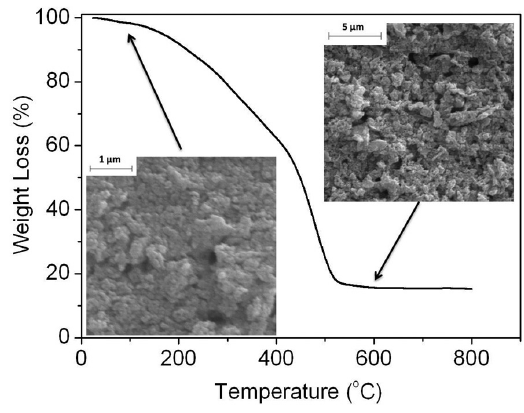
Figure 5. Thermogravimetry (TG) obtained of the deposited powder (heat treated at 90 o C/12h and then removed of the substrate). The insert presents the SEM images of the surface morphology of BTZ in green form, heat treated at 90 °C/12h and 600 °C/2h. The thick films were deposited with EtOH+Acac suspension, nanoparticles concentration of 5mg/cm 3 , deposition time of 120s and electric field of 133V/cm.